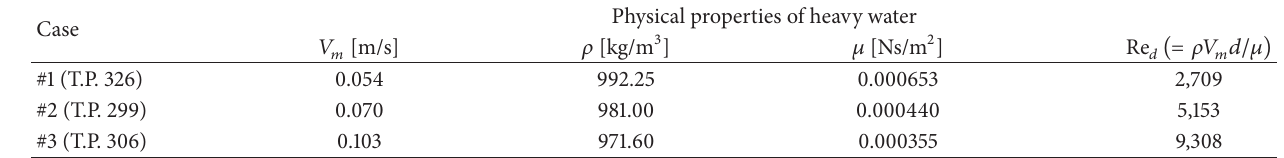
Table 2: Three cases in STERN laboratory experiment, 𝑑 = 33.02 mm.